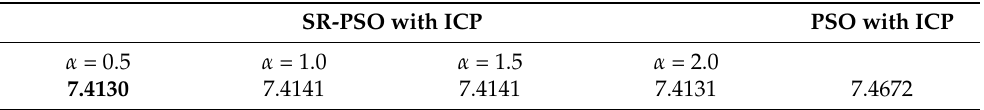
Figure 13. The best SR-PSO with ICP registration results for the pairs ( a ) 1 and 2; ( b ) 2 and 3; ( c ) 3 and 4; ( d ) 4 and 5; ( e ) 5 and 6 of the orthodontic-tooth model.